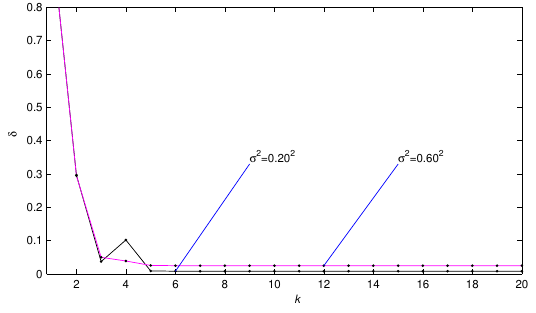
Figure 1. The estimation errors δ versus t